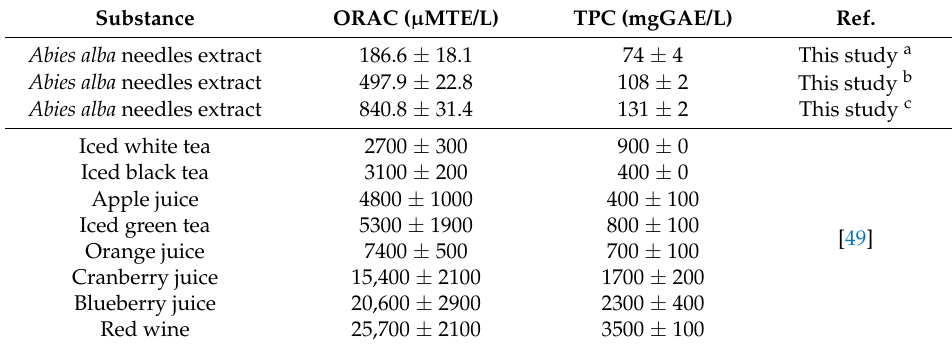
Table 5. ORAC antioxidant activity and TPC levels, with the respective standard deviations, from this study, and from a previous study (the TPC levels were referred to the volume of 1 L).